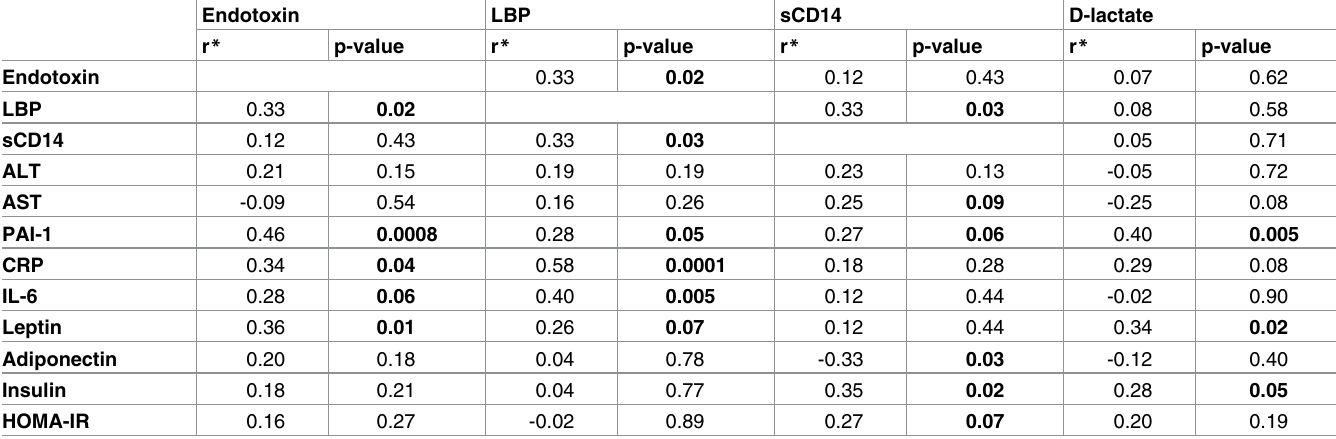
Table 2. Correlation analysis of markersof intestinal barrier function, inflammation and metabolic